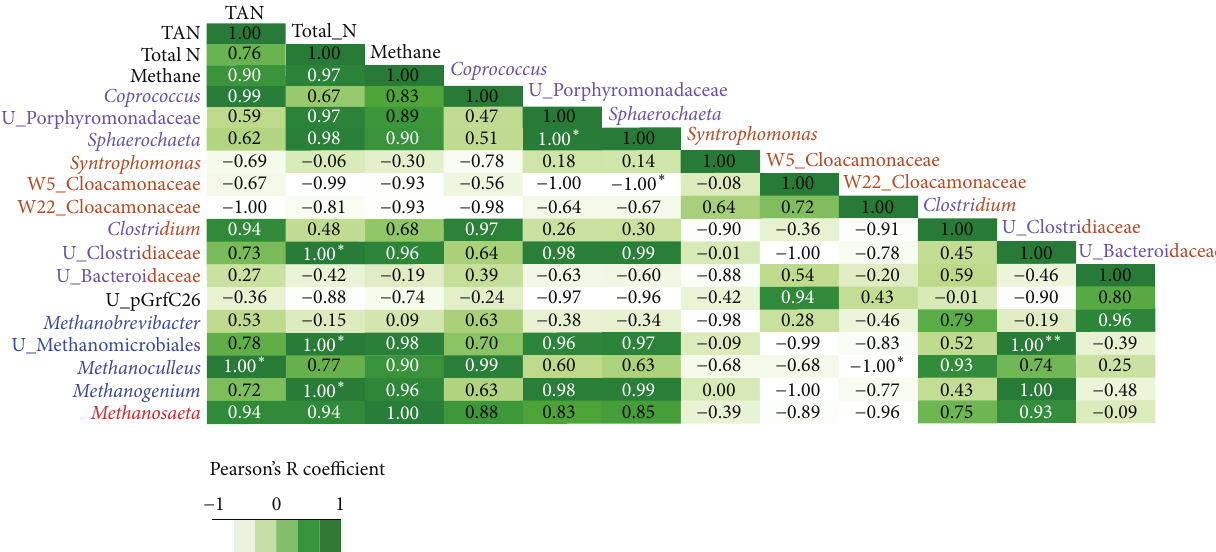
Figure 6: Parametric correlation (Pearson’s R coefficient) of methane production, total NH 3 -N (TAN) concentration, and key Bacteria and Archaea identified during operation of the anaerobic reactor treating swine waste. Phylotypes in purple, orange, blue, and red represent fermenters, syntrophs, and hydrogenotrophic and acetoclastic methanogens, respectively. Phylotypes that are most similar to fermenters and syntrophsareindicatedinacombinationofpurpleandorangecolors. Note . ∗ Correlationissignificantatthe0.05level(2-tailed). ∗∗ Correlation is significant at the 0.01 level (2-tailed). The statistical analysis was not corrected for multiple comparisons.